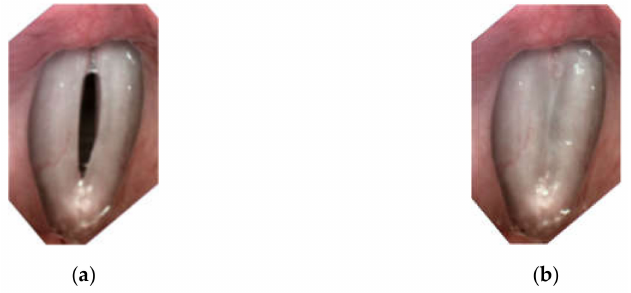
Figure 1. Images of the glottis for the normophonic subject N3 for the maximum opening ( a ) and maximum closing ( b ) of the vocal folds correspondingly.